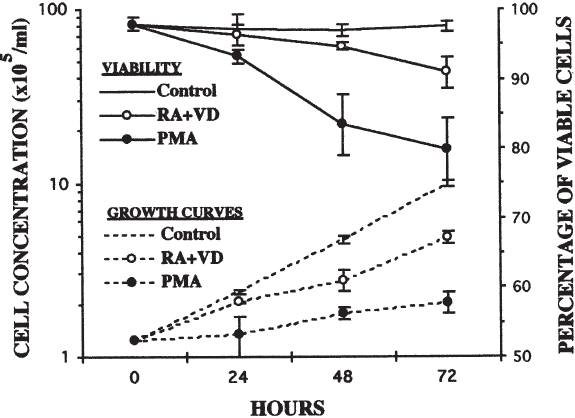
Fig. 1. Growth and viability of control and induced cells. Cells were rinsed and seeded at initial concentration of 1 . 25 × 10 5 /ml with the different inducers. Cell concentration (dashed lines, left logarithmic ordinate) and percentage of viable cells (solid lines, right ordinate) were followed during three days.